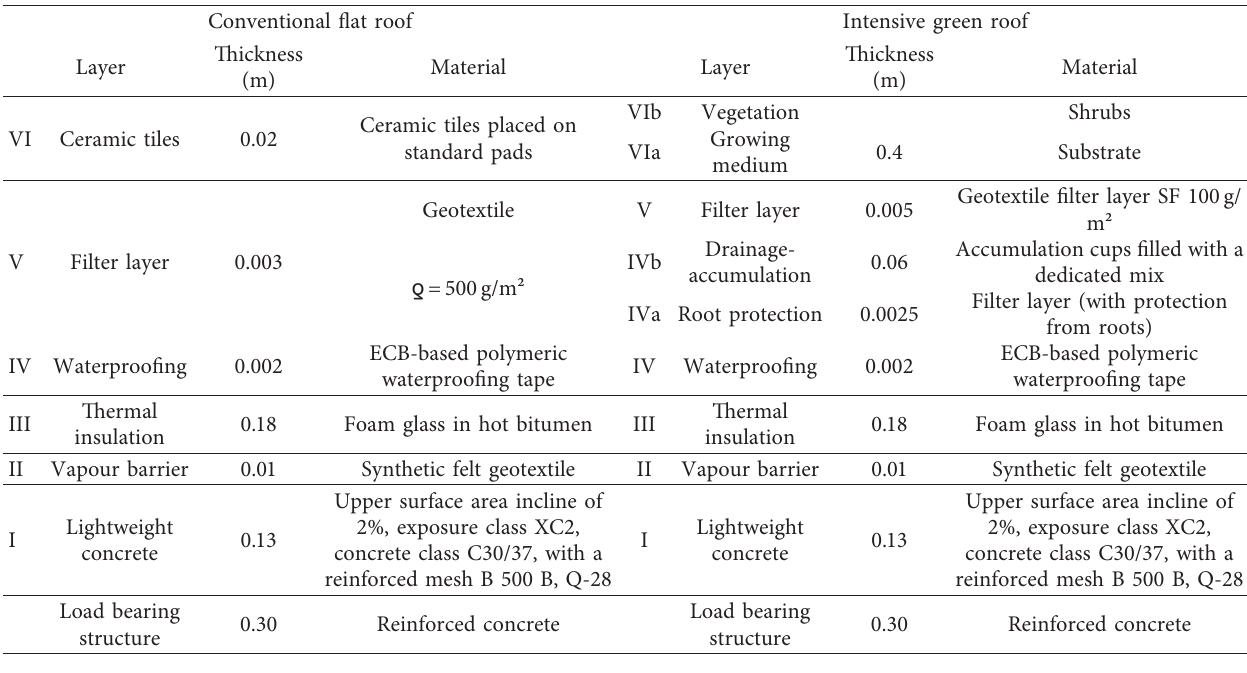
Table 1: Conventional flat and intensive green roof layers (placed on a load bearing structure) characteristics and thickness (the table is structured by authors upon data collected from cost estimate for the building under construction).